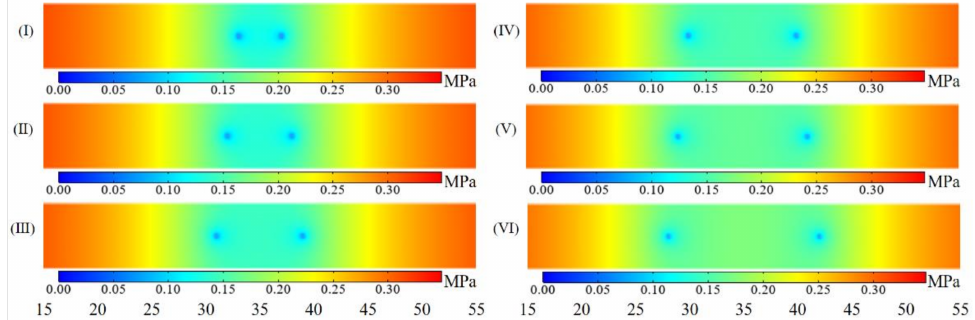
Figure 23. Three-dimensional cloud chart of gas pressure distribution around boreholes with different spacing: ( I ) 4 m; ( II ) 6 m; ( III ) 8 m; ( IV ) 10 m; ( V ) 12 m; ( VI ) 14 m.